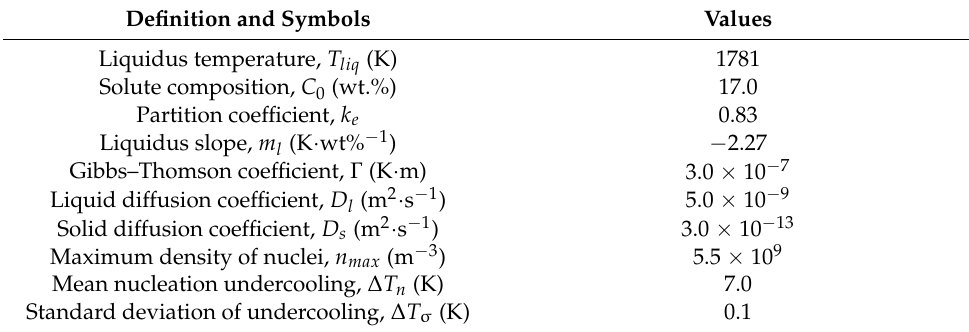
Table 1. The thermal properties of the ferritic stainless steel Cr17 used in the simulation. Definition and Symbols Values Liquidus temperature, T liq (K) Solute composition, C 0 (wt.%) 17.0 Partition coefficient, k e